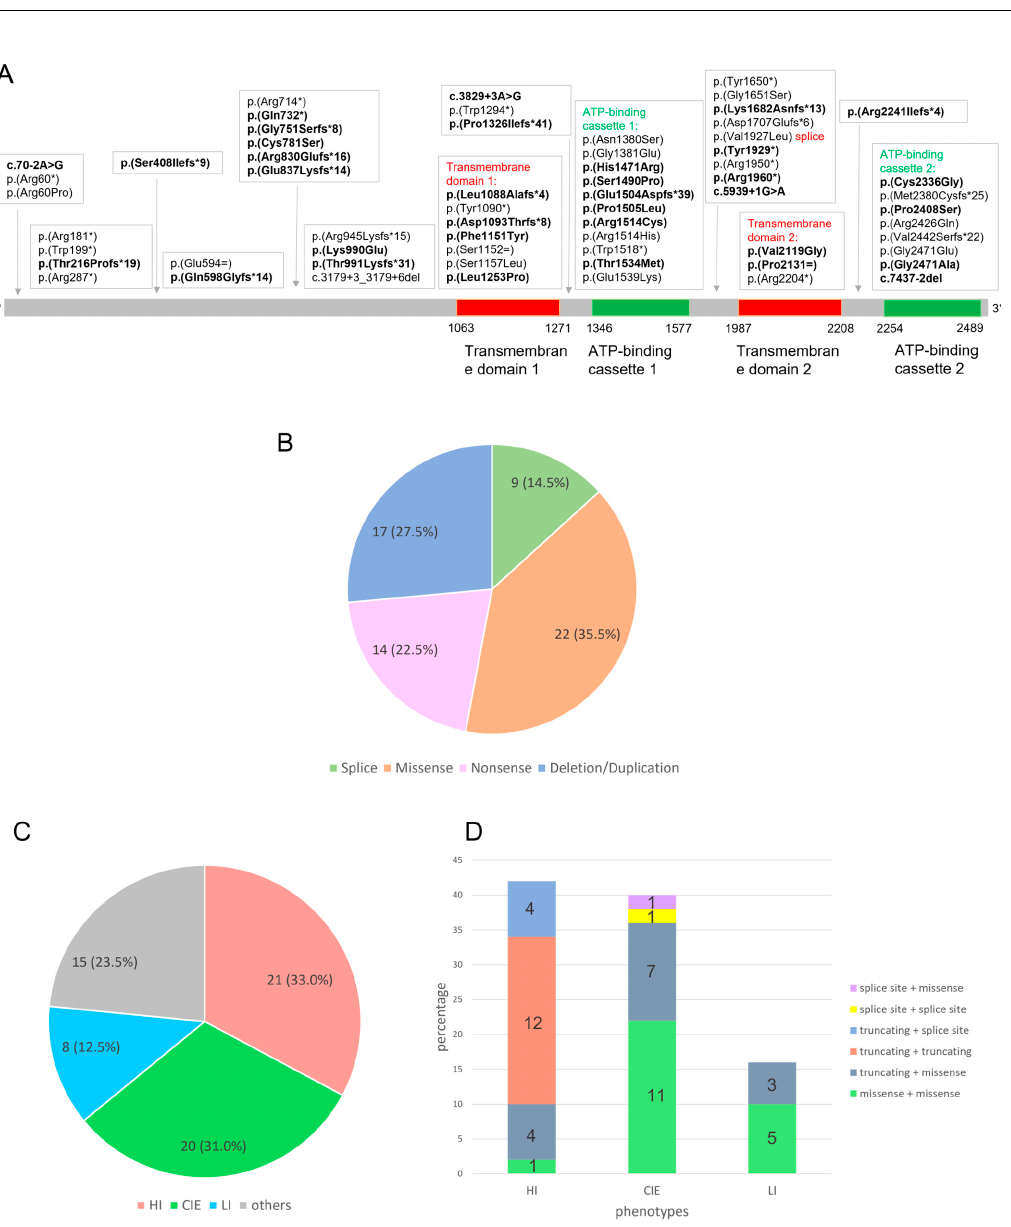
Figure 1. ( A ) Distribution of all mutations in the ABCA12 gene in our cohort of 62 patients. A total of 34 novel mutations are shown in bold and 28 previously published mutations are shown in non-bold. Red: Transmembrane domain 1 and 2 in the ABCA12 protein. Green: ATP-binding cassettes 1 and 2 in the ABCA12 protein. The transmembrane domains range from amino acids 1063 to 1271 and 1987 to 2208; the ATP binding cassettes range from amino acids 1346 to 1577 and 2254 to 2489, including the AAA domains amino acids 1370 to 1554 and 2282 to 2467 (InterPro 92.0 [22], SMART 9.0